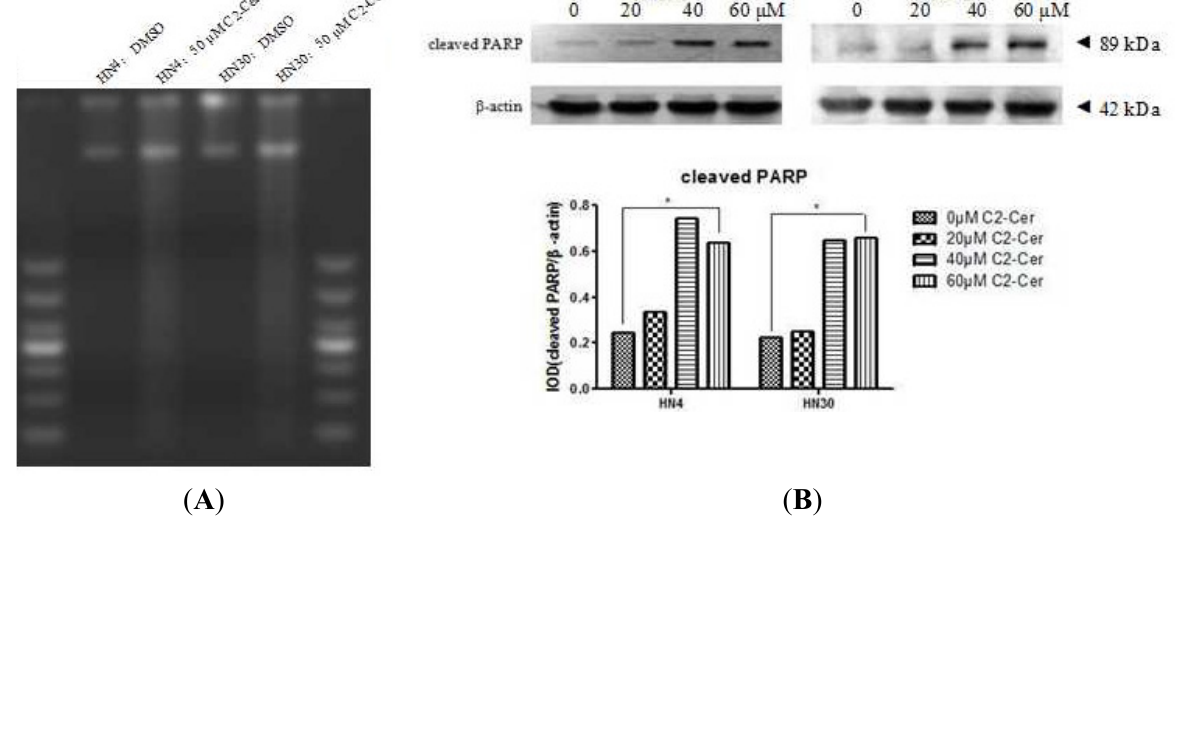
Figure 3. ( A ) DNA fragmentation assay. Cells were treated with dimethyl sulfoxide (DMSO) and 50 μ M C2-Cer. DNA was extracted and subjected to 2 g/L agarose gel electrophoresis. DNA from C2-Cer-treated cells showed fuzzy and continuous DNA ladders; ( B ) Western blotting. Cleaved poly (ADP-ribose) polymerase (PARP) was increased after treatment with C2-Cer (0, 20, 40, 60 μ M, respectively) compared with controls; ( C ) Hoechst 33342/PI double staining. Cells were treated with different concentrations of C2-Cer (0, 20, 50 μ M, respectively). Necrotic cells were observed after exposure to C2-Cer in a concentration-dependent manner (necrotic cells, Hoechst 33342+/PI+, arrow). ( * : p <